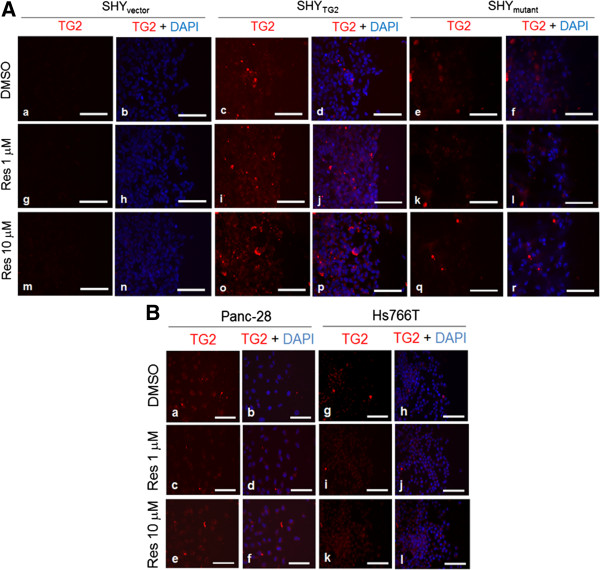
Determination of extracellular levels of TG2 in response to resveratrol. Representative immunofluorescence images showing extracellular TG2 level (red) in SHYvector, SHYTG2, and SHYmutant(A), and Panc-28 and Hs766T cells (B). After 48 h with or without resveratrol (1 or 10 μM) treatment in scratch assays, extracellular TG2 was detected using anti-TG2 antibody. Nuclei were stained with DAPI and visualized under fluorescence microscopy. Pictures are representative of at least 3 independent experiments. Scale bar = 100 μm.